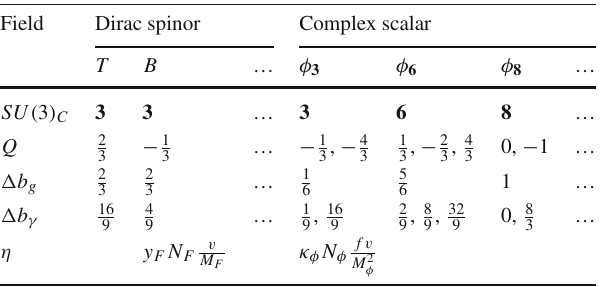
Table 1 Colored particles that may run in the loop represented by the blob in Fig. 1, and their possible parameters. We assume that they are SU ( 2 ) L singlets. The electromagnetic charge Q is fixed to allow a mixing with either top or bottom quark for the Dirac spinor and a Yukawa coupling with a pair of SM fermions for the complex scalar; see Appendix C. In the last row, F stands for T or B Field Dirac